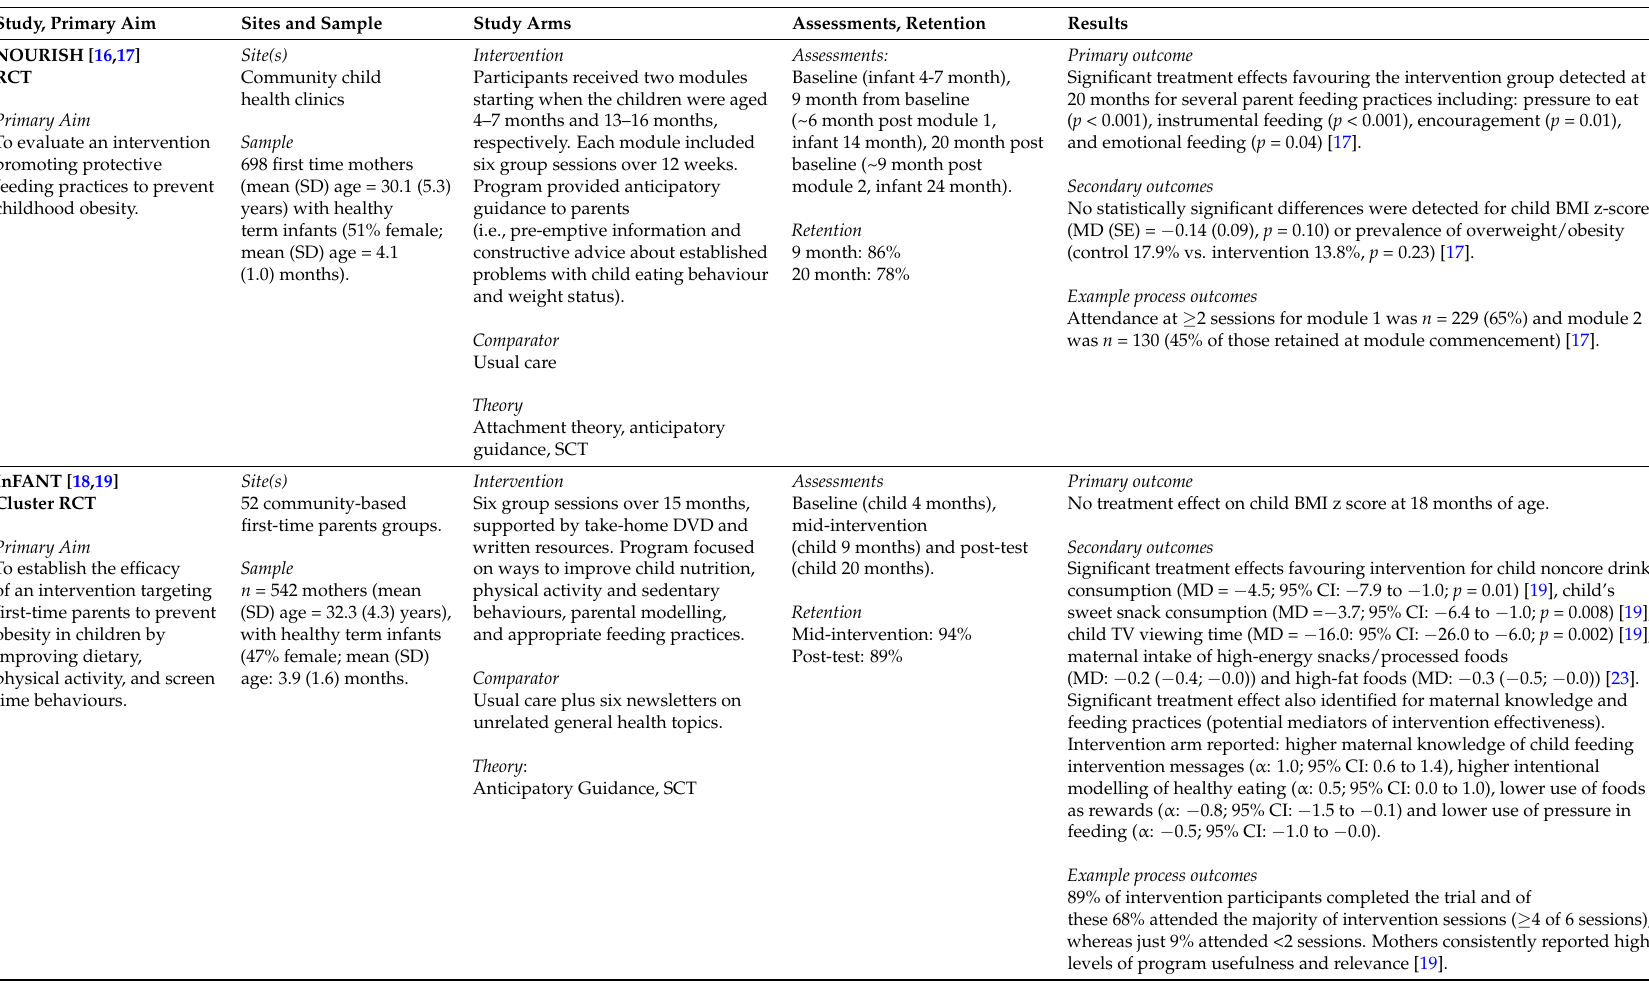
Table 1. Summary of family-based childhood obesity prevention randomized controlled